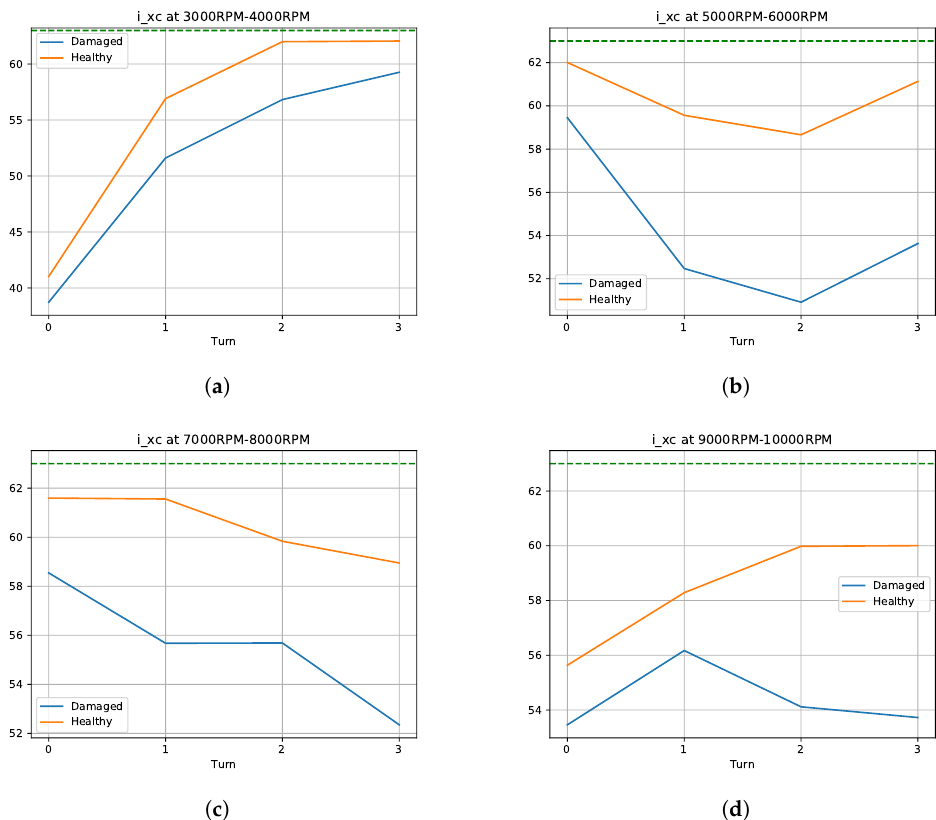
Figure 17. i xc indicator behaviour during speed variation for healthy and faulty motors. ( a ) i xc —3000RPM–4000RPM; ( b ) i xc —5000RPM–6000RPM; ( c ) i xc —7000RPM–8000RPM; ( d ) i xc